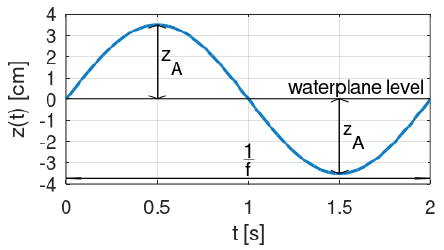
Figure 3. Two-dimensional progressive sinusoidal wave on the water surface.